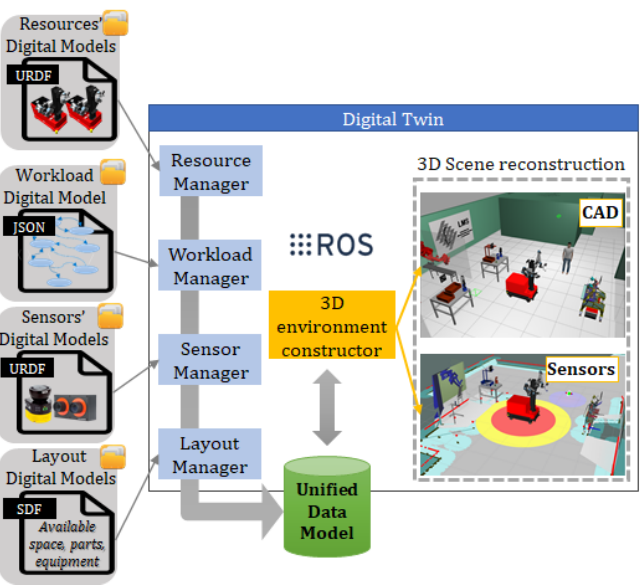
Figure 6. Digital Twin system architecture.